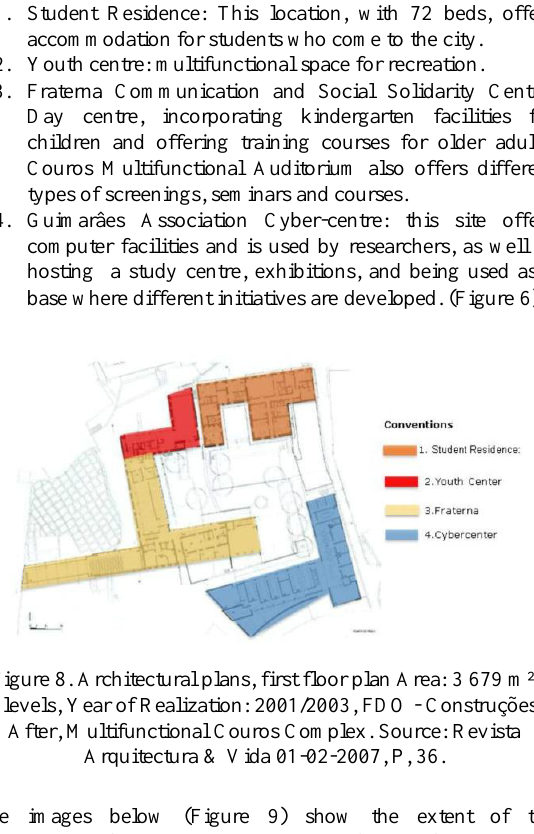
Figure 6. Map showing site limits and persistent morphology